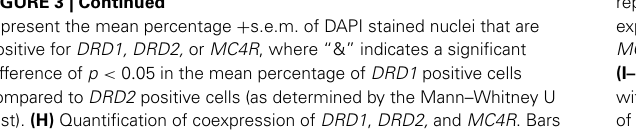
represent the mean percentage ( + s.e.m.) of cells expressing DRD1 also expressing DRD2 , the percentage of DRD1 expressing cells also expressing MC4R and the percentage of DRD2 expressing cells also expressing MC4R . (I–M) Example pictures of MC4R expression in the five regions